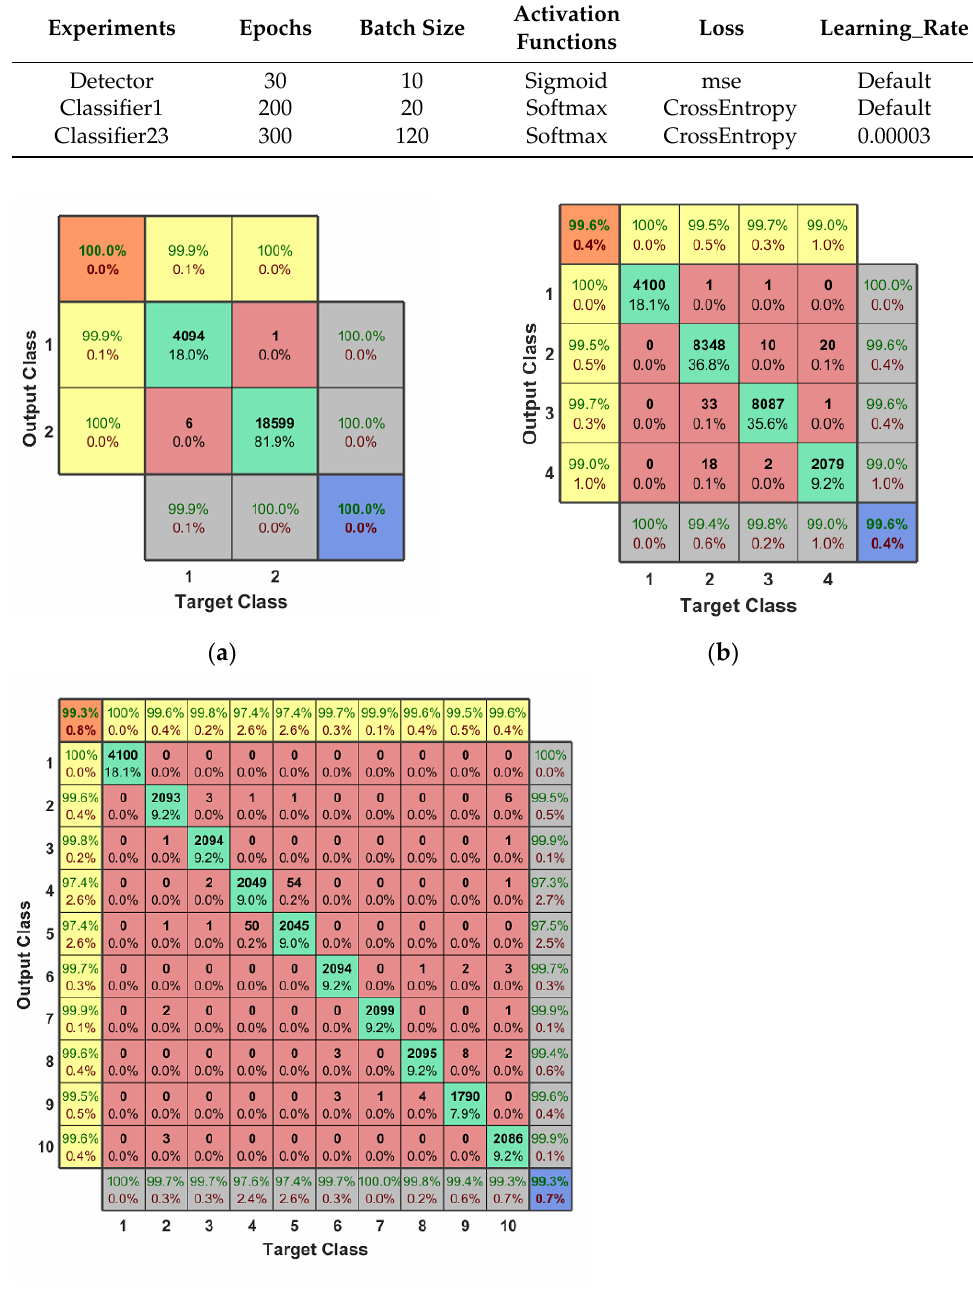
detection network in Table 1 in Section 3.2. Using 10-fold cross-validation, 30 rounds are trained in batches of 10, and the last activation layer is chosen as a Sigmoid function as well as convergence using the MSE loss function. The final binary classification accuracy and F1 scores reach 100%, as shown in Figure 4a. Table 4. Selection of Experimental Parameters. Experiments